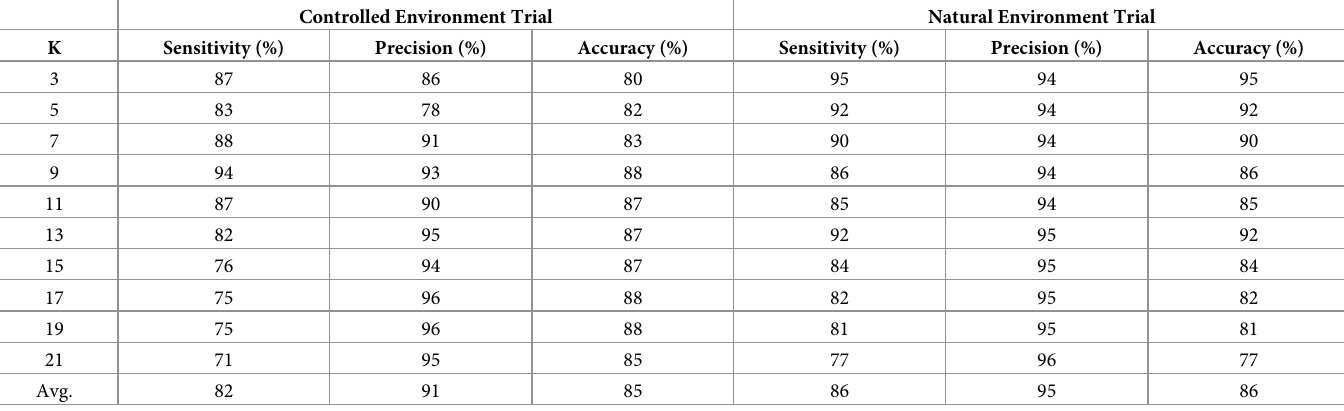
Table 2. The average of sensitivity, precision, and accuracy values from Leave-One-Subject-Out Cross-Validation using KNN model for k in the range of 3 to 21 for controlled environment and natural environment